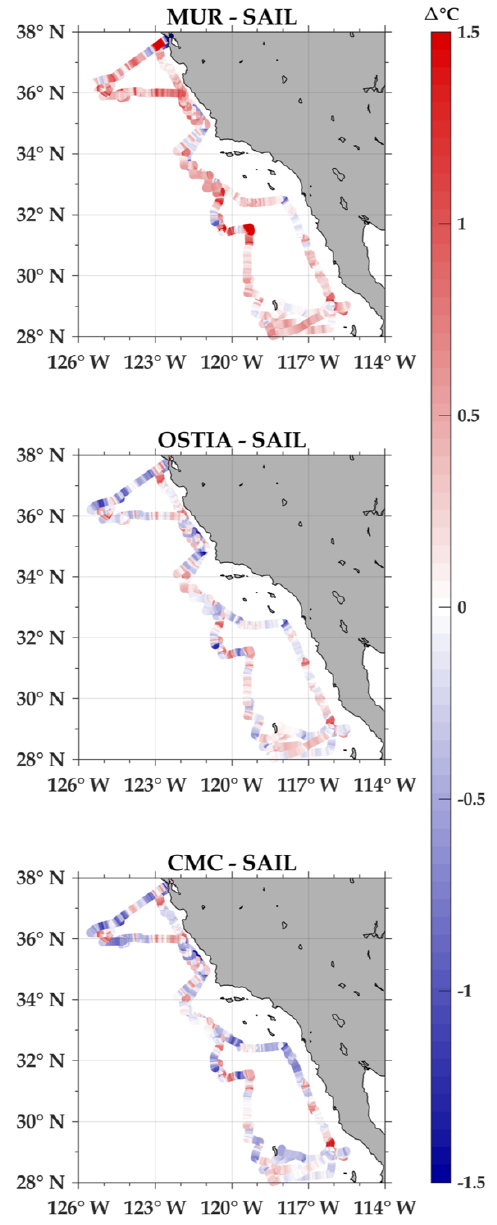
Figure 5. Difference plots for each of the remotely sensed SST products and the Saildrone-derived SST.